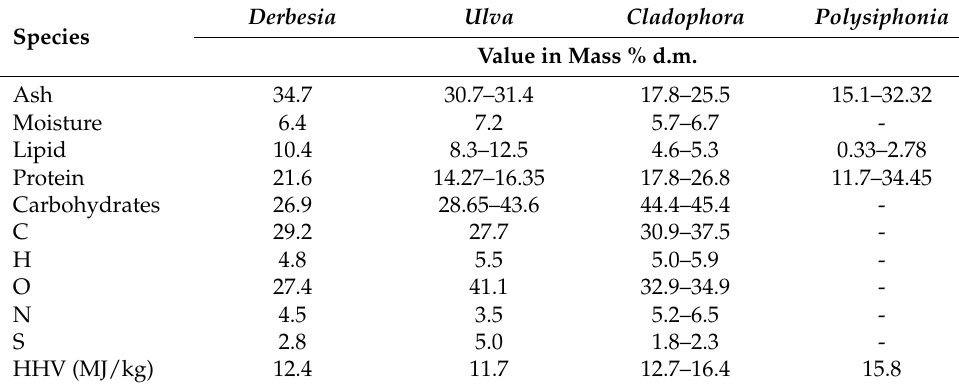
Table 1. The composition of the Baltic Sea